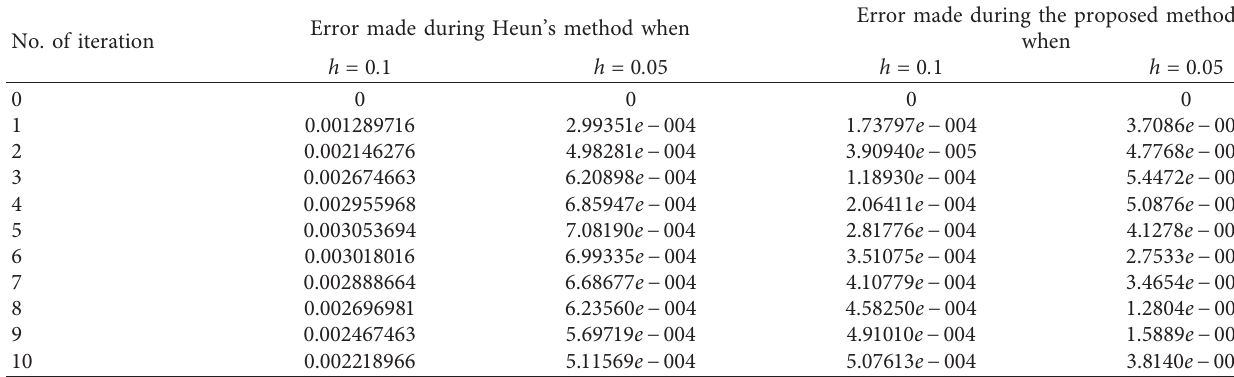
Table 2: Errors made by the stated numerical methods for Example